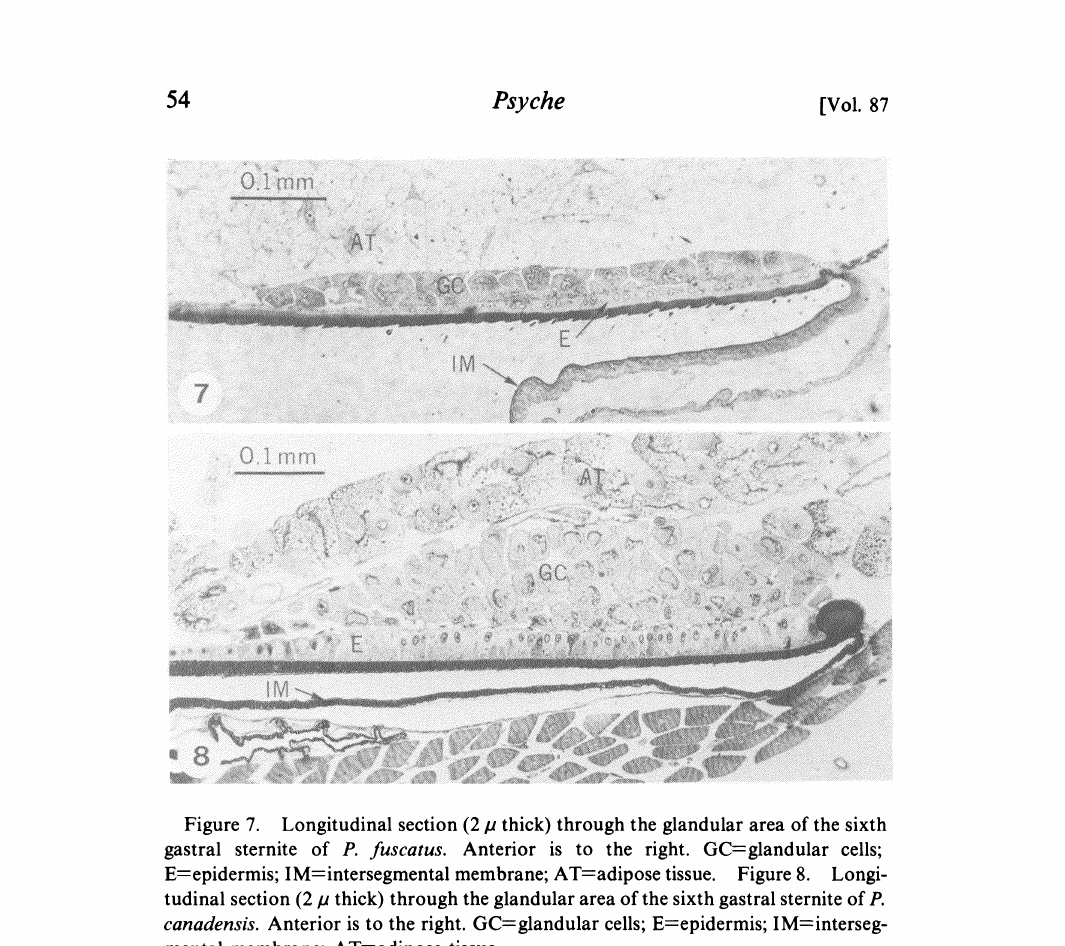
Figure 7. Longitudinal section (2 At thick) through the glandular area of the sixth gastral sternite of P. fuscatus. Anterior is to the right. GC--glandular cells; E-epidermis; IM--intersegmental membrane; AT=adiposetissue. Figure 8. Longi- tudinal section (2 At thick) through the glandular area of the sixth gastral sternite of P. canadensis. Anterior is to the right. GC=glandular cells; E-epidermis; IM--interseg- mental membrane; AT=adipose